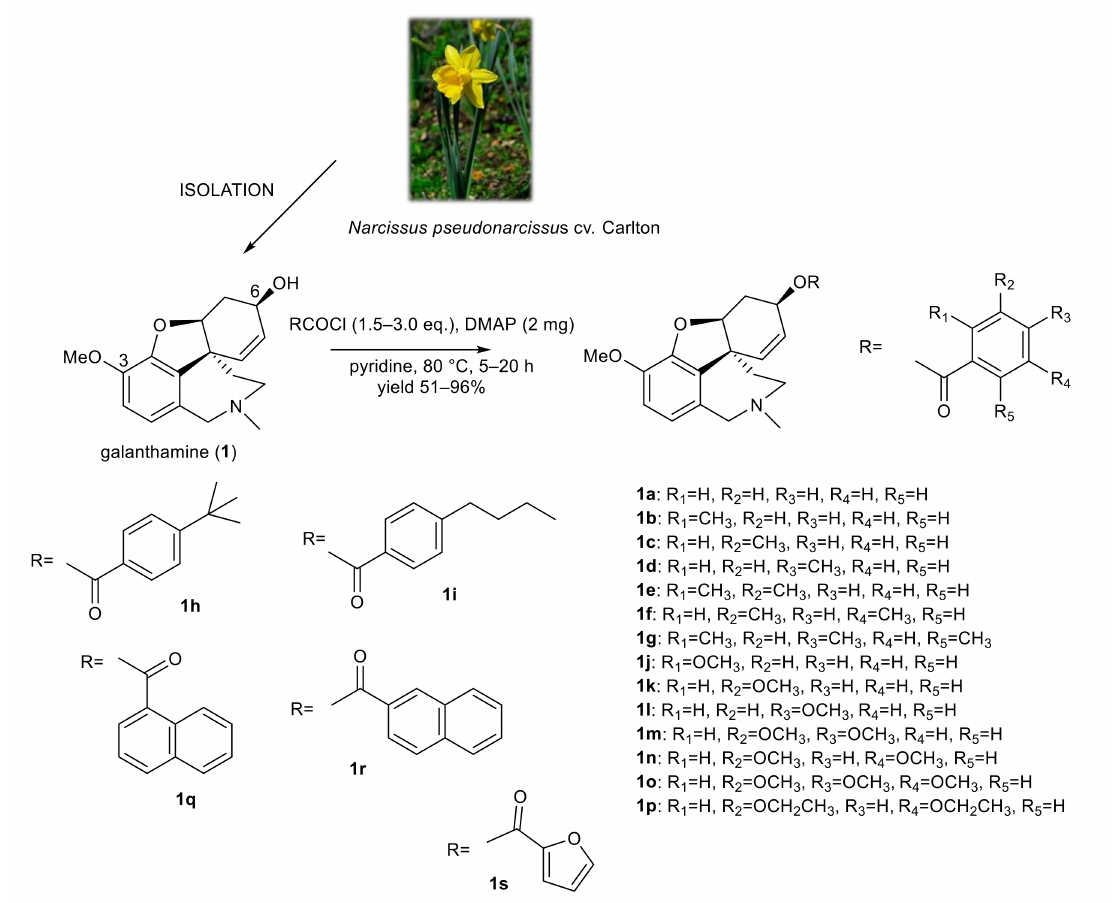
Figure 1. Chemical procedures affording galanthamine derivatives ( 1a – 1s